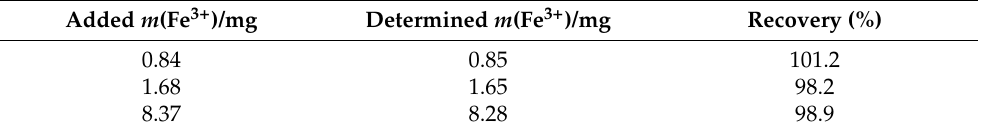
Table 6. Determination of ferric cations in standard solution at pH = 1.